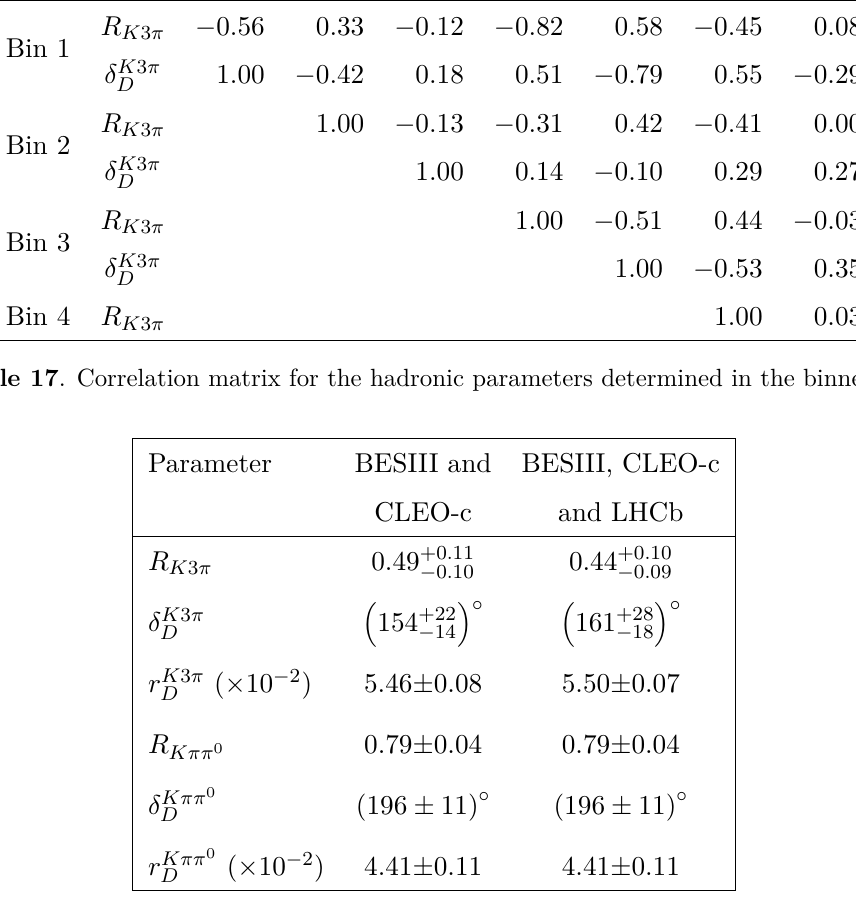
Table 18 . Results for the global fit to the BESIII and CLEO-c data, and the BESIII, CLEO-c and LHCb